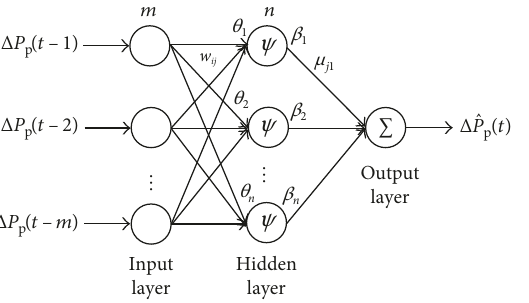
Figure 3: The structure of the neural network observer.